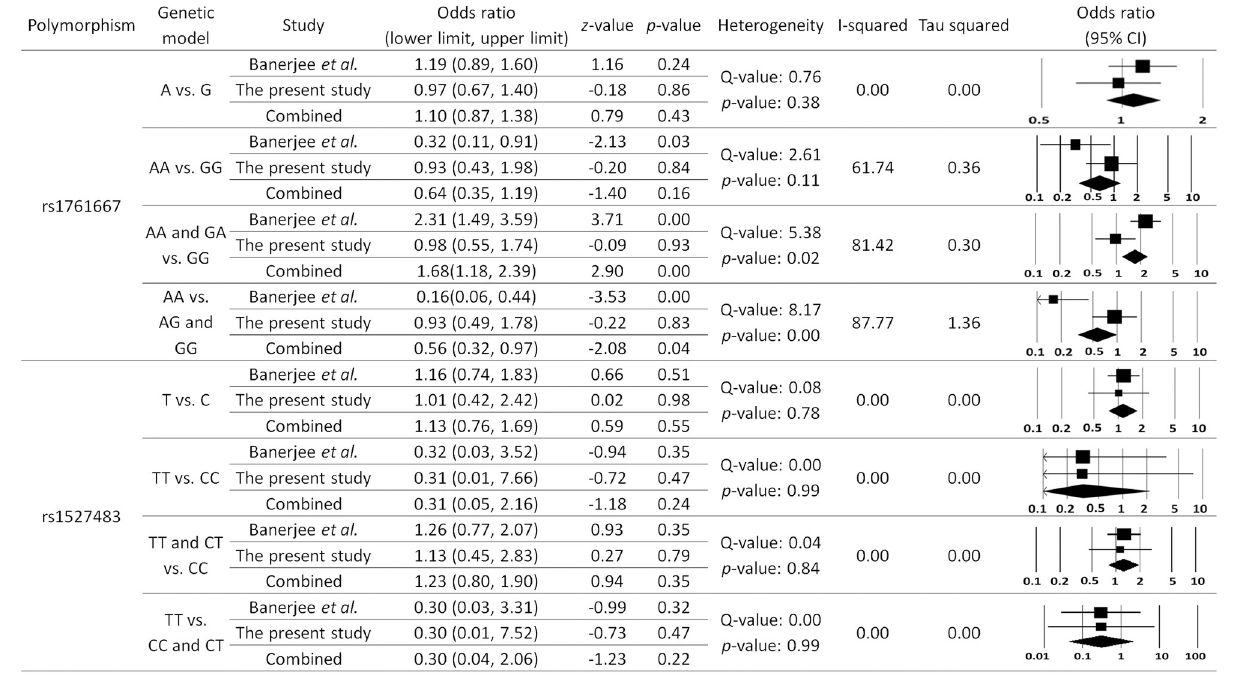
Fig 6. Meta-analysis for both polymorphisms in T2DM group compares to control group. Random effect model is used with all analyses. Based on different genetic models, the frequencies of different genotypes and alleles were extracted from the two studies (i.e., the present study and Banerjee et al ., 2010 study [24]) and plugged in the software to do the calculations shown